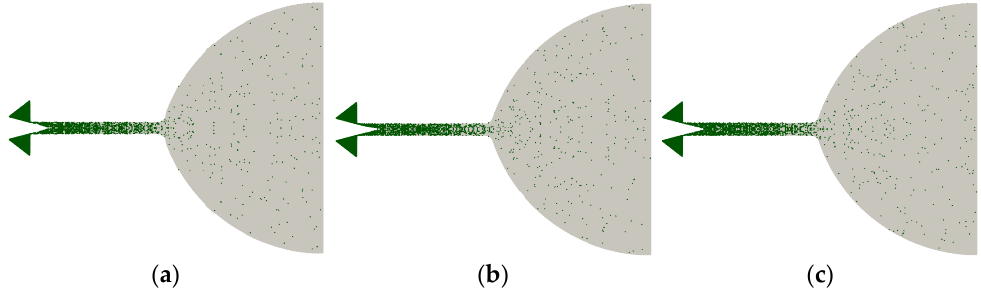
Figure 16. Molecular particle position with different gas temperature at t = 0.1 ms. The inlet nitrogen pressure is maintained at 0.15 MPa. Each green point denotes a molecular group. ( a ) 285.82 K. ( b ) 293.15 K. ( c ) 300.48 K.